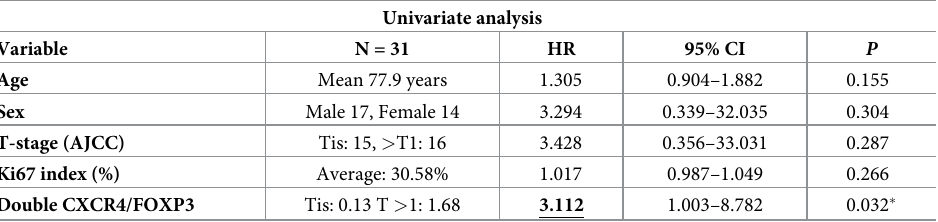
Table 4. Relationship between progression-free survival and various clinicopathologic and molecular